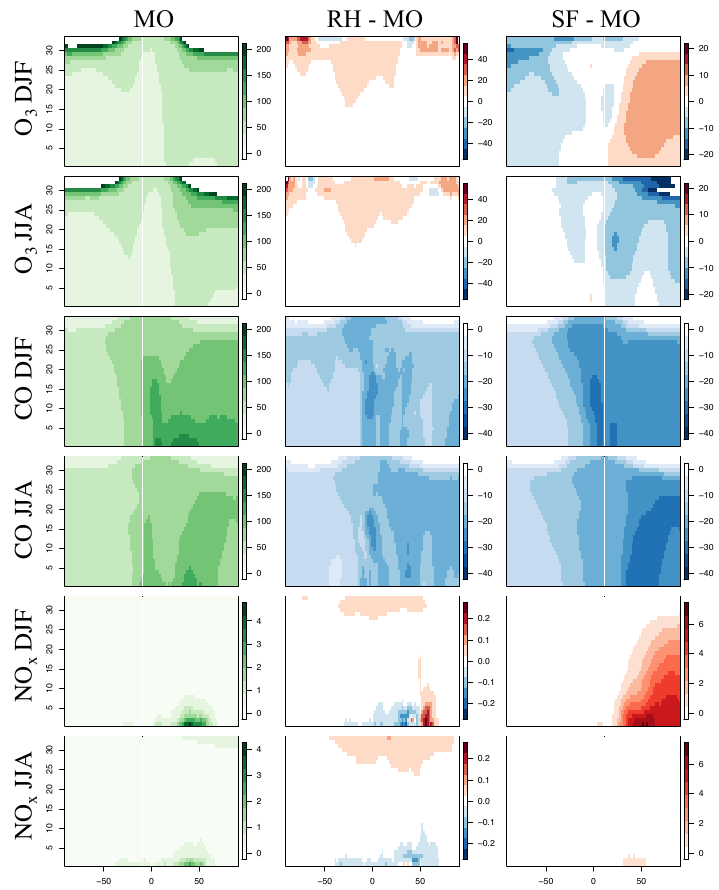
Figure 4. Zonal plots of seasonal O 3 , CO, and NO x for MO, the difference between RH and MO, and between SF and MO for the year 2015. The vertical axis is the model level, and the chemical units are in ppb. Please note the different vertical axis in each row. Cool colors for the different panels indicate MO is higher, and warm colors indicate that RH or SF is